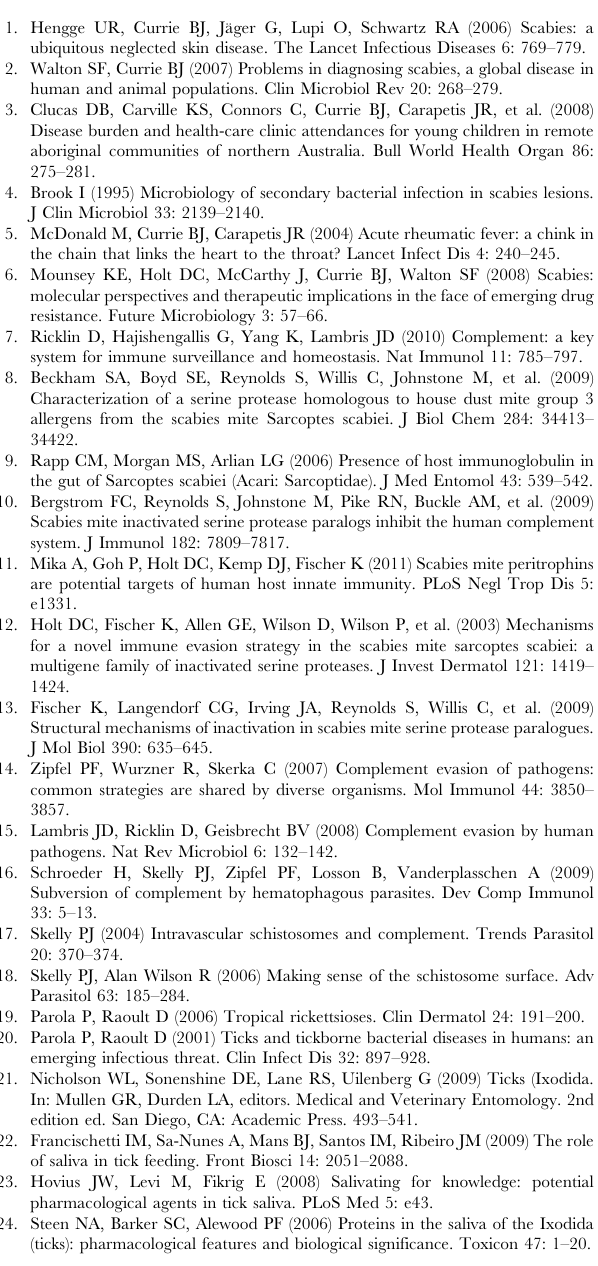
temperature. Samples were electrophoresed on 10% SDS-PAGE as indicated in the labels above each lane. The positions of the catalytic chains of the enzymes are indicated [e.g. C1r (c)]. The positions of the complexes between hC1r and hC1s and hC1i are also indicated. Figure S3 Interaction of scabies mite serpins with human MASP-1 and MASP-2. Increasing concentrations of purified recombinant MASP-1 (M1) or MASP-2 (M2) were incubated with SMSB3 (B3) and SMSB4 (B4) for 1 h at room temperature. Samples were separated on 10% SDS-PAGE as indicated in the labels above each lane shown. Molecular weight markers (Precision Plus Protein TM Dual Colour Standard, BIO RAD) are shown in the first lane at the left of each SDS-PAGE